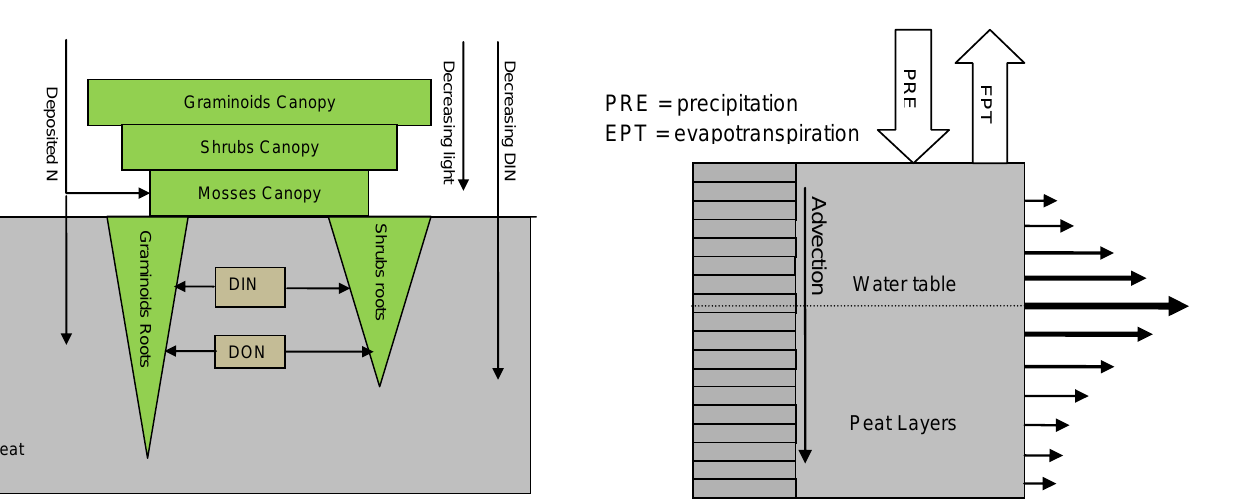
Figure 4. Schematic soil water flow